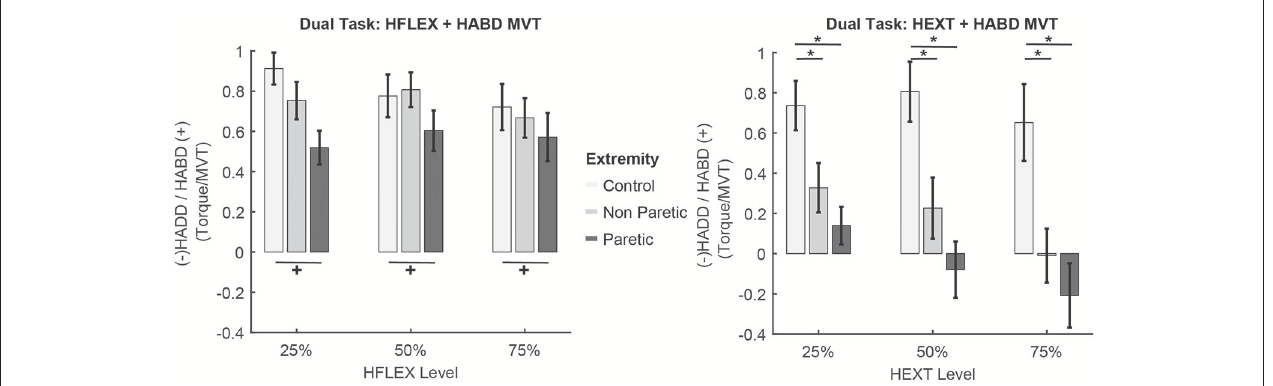
FIGURE 2 | Results for the combined submaximal hip flexion + hip abduction MVT task and hip extension + hip abduction MVT task. x-axis indicates the percentage of hip flexion/extension and the y-axis indicates the volitional hip abduction or spontaneous hip adduction generated, normalized by hip abduction MVT. Percentages reported in the main text correspond to this normalized value × 100%. Off-white = control, gray = non-paretic, black = paretic. + p < 0.05 Sidak post-hoc significant differences across lower extremities in the % hip abduction torque achieved. * p < 0.05 Sidak post-hoc significant differences across levels and lower extremities in the % hip abduction torque achieved. Error bars show standard errors of the mean.